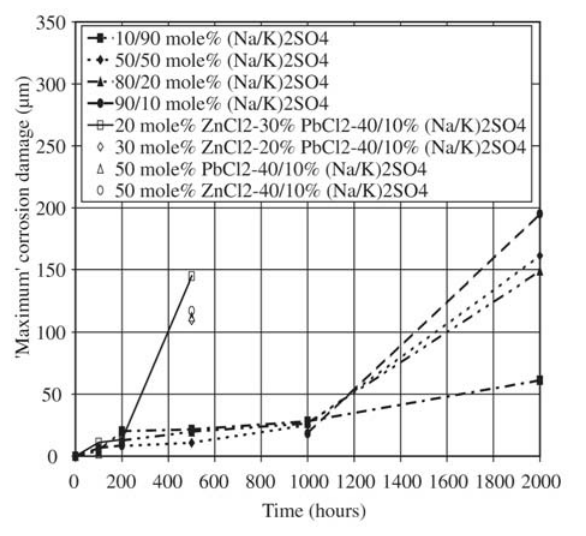
Figure 5. Effect of different deposit compositions on ‘maximum’ corrosion damage to IN738LC at 700 °C